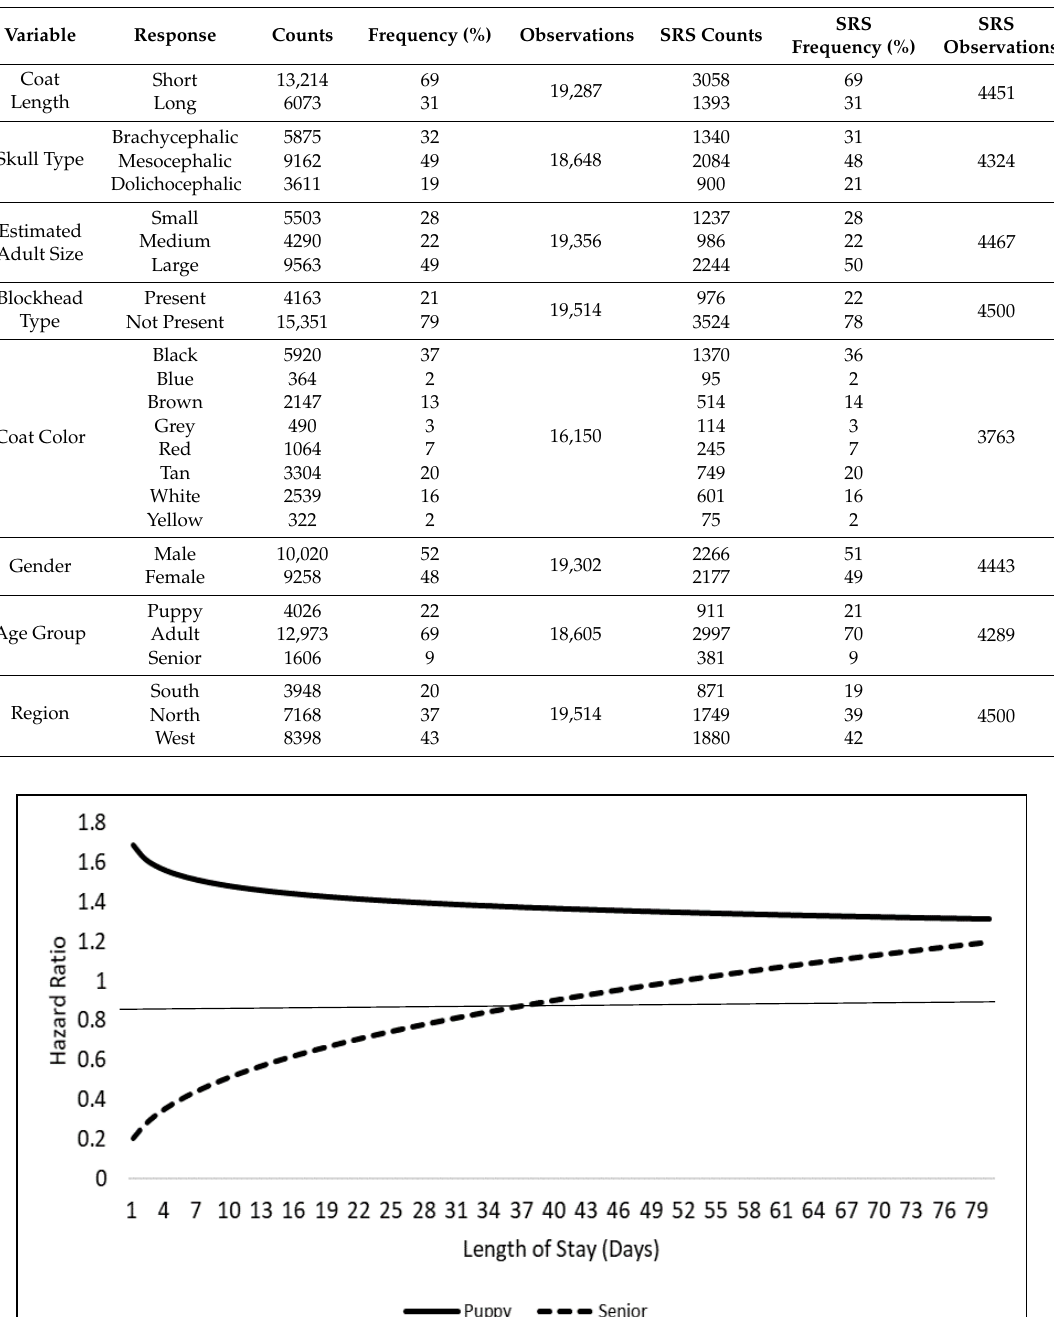
Figure 2. Model adjusted estimated adult size by length of stay interaction displayed as hazard ratios, estimated from the simple random sample of 4500 dogs compared to the referent large group. Skull type also had an interaction with time ( p < 0.001) and did not meet the proportionality assumption. Hazard ratios for brachycephalic and dolichocephalic dogs compared to mesocephalic dogs were graphed over the LOS in days (Figure 3). The hazard of adoption of dolichocephalic dogs compared to mesocephalic dogs was not different over time ( p = 0.473). A solid line is graphed at HR = 1 used to demonstrate “null” HR value.